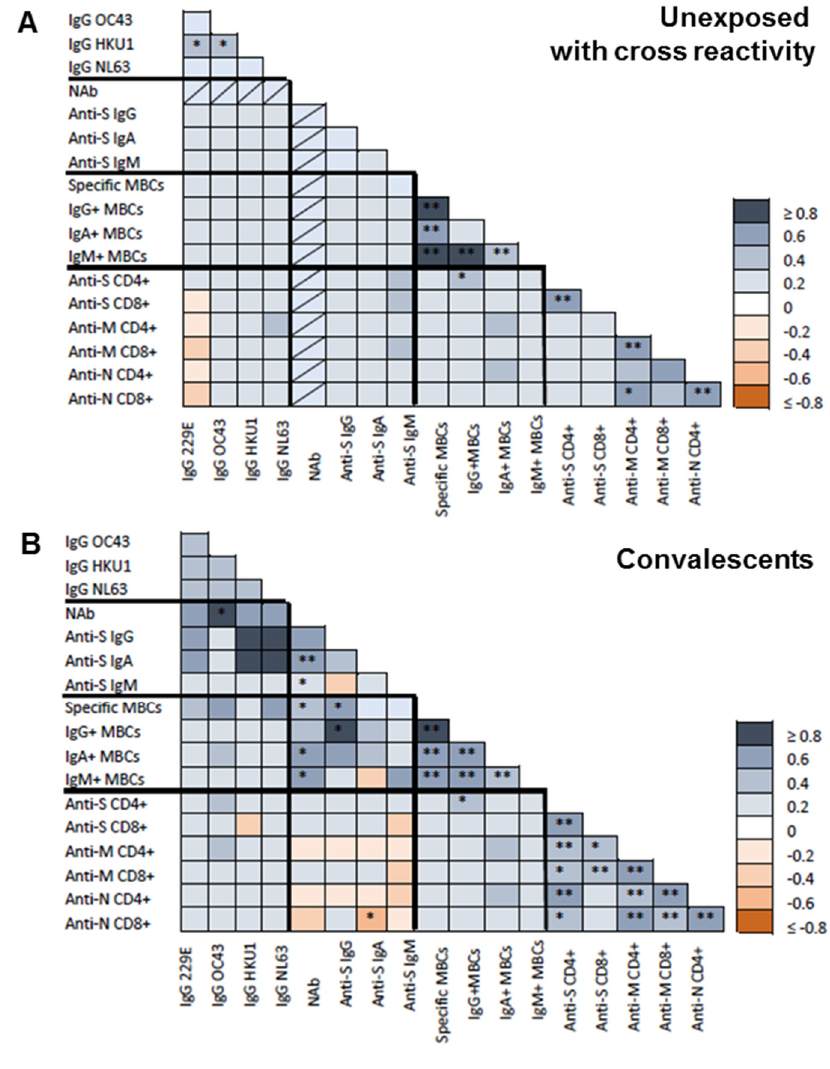
Figure 2. Baseline correlations between antibodies against common human coronavirus (HCoVs), SARS-CoV-2 spike-specific (IgG, IgA, and IgM) antibodies, neutralizing antibodies (NAB), specific memory B-cells (MBCs) and IgG+, IgA+, and IgM+ MBCs isotypes, CD4+ and CD8+ T-cell responses to SARS-CoV-2 spike (S), membrane (M), and nucleocapsid (N) proteins. ( A ) Spearman test heatmap analysis of the different variables in unexposed subjects with cross-reactivity. ( B ) Spearman test heatmap of the different variables in convalescent individuals. The grey color represents a positive correlation and the red color a negative correlation. The intensity of the color indicates the R 2 coefficient. Statistically significant when p < 0.05. * = p < 0.05, and ** = p < 0.01. Of note, HCoV antibody levels did not correlate with SARS-CoV-2 anti-S or anti-N IgA or IgM antibodies. Nevertheless, OC43 antibody levels significantly correlated with SARS-CoV-2 anti-N IgG (r = 0.463; p = 0.05) and neutralizing (r = 0.857; p = 0.014) antibodies at inclusion in convalescent individuals (Figure 2B). Also, only CD4+ T-cell against S pro- tein tended to be associated with HCoV OC43 antibodies (r = 0.286, p = 0.090). Finally,